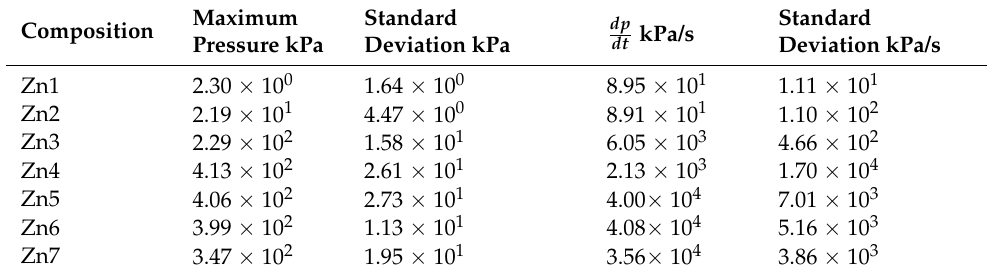
Table 5. Pressure